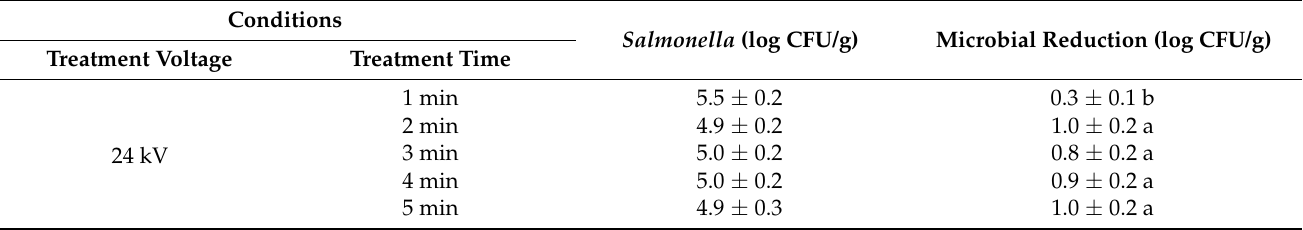
Table 1. Effect of the treatment time of atmospheric dielectric barrier discharge cold plasma treatment on Salmonella